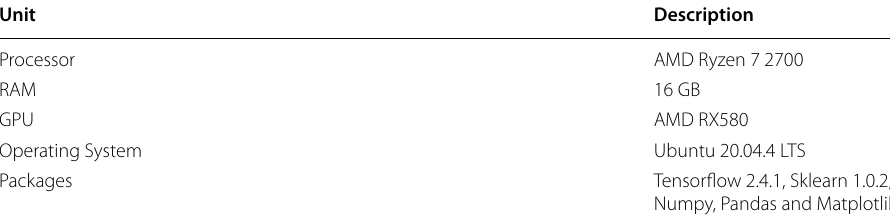
Table 1 Hardware and environment specification